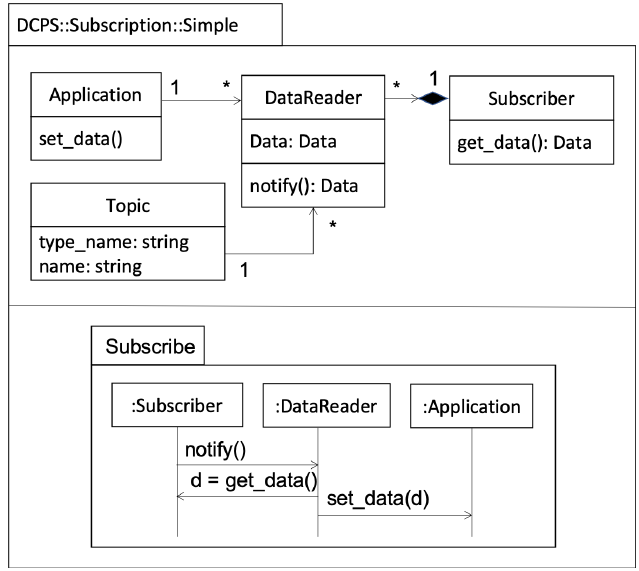
Figure 12. Simple subscription